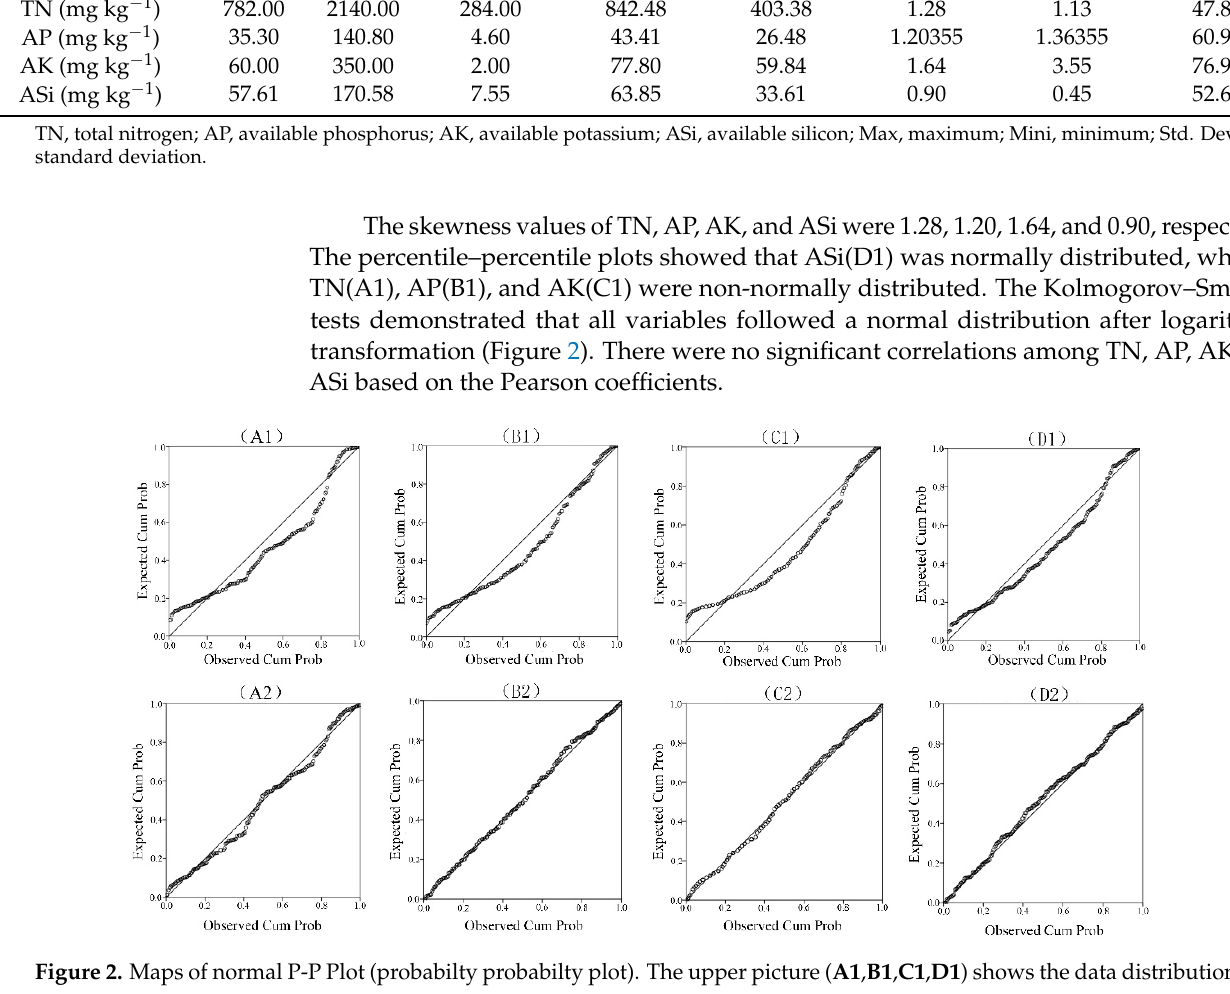
Table 1. Descriptive statistics of N, P, K and Si in soils.